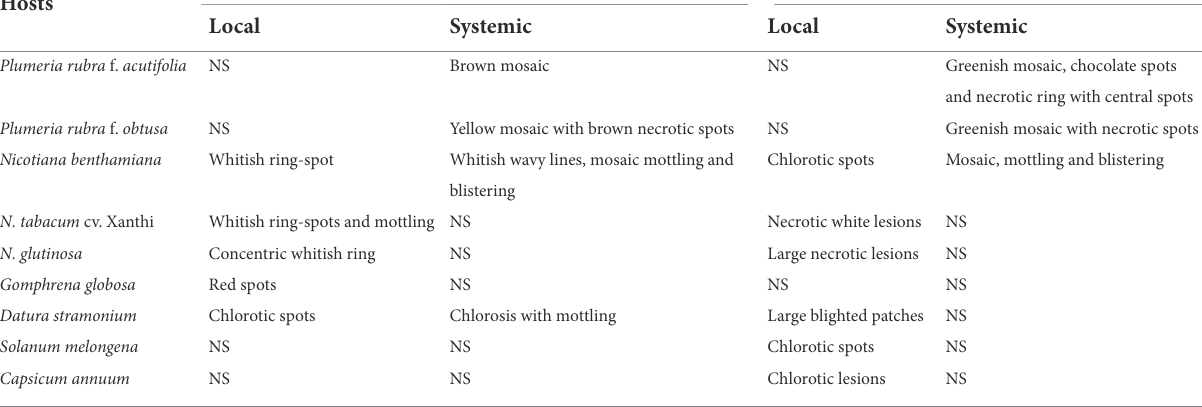
TABLE 1 Comparison of local and systemic symptoms of plumeria mosaic virus isolate, PluMV-Plu-Ind-1 and frangipani mosaic virus isolate, FrMV- Ind-1 on different plant species. PluMV-Plu-Ind-1 symptoms FrMV-Ind-1 symptoms Hosts Local Systemic Local Systemic Plumeria rubra f. acutifolia